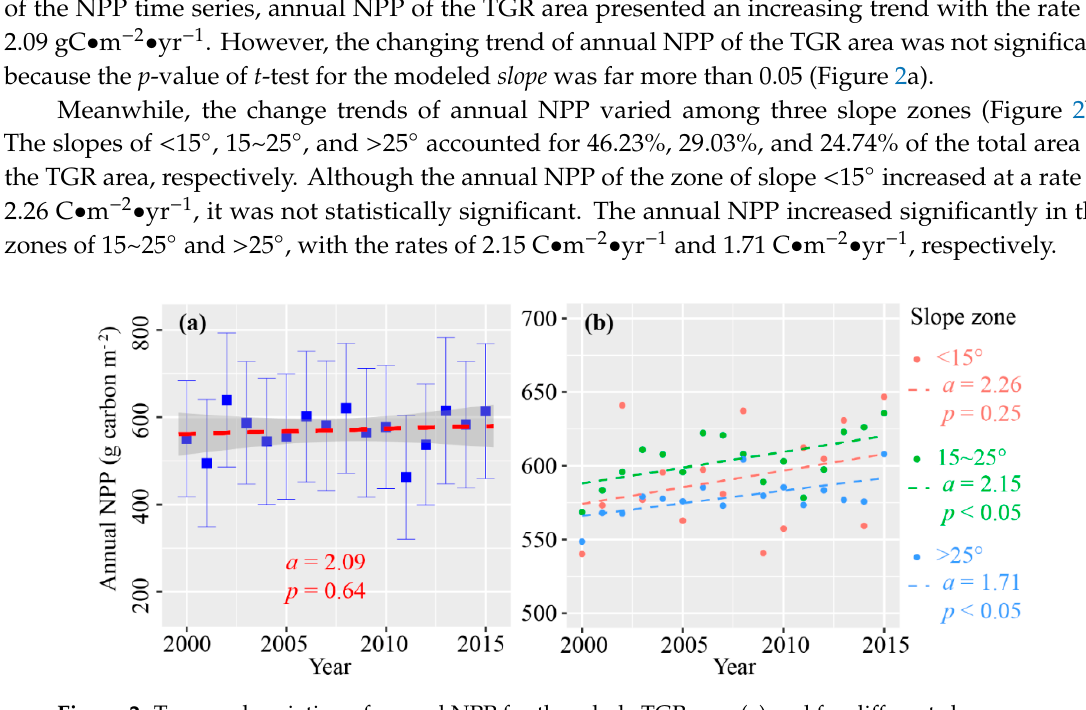
Figure 2. Temporal variation of annual NPP for the whole TGR area ( a ) and for di ff erent slope zones ( b ). Note: The dotted line indicates the linear fitting from 2000 to 2015, the a describes the changing trend. Meanwhile, the t statistic was applied to test the significance of the modeled slope , and the p value documents the significance. In the figure ( a ), error bars extending from the means document the standard deviation of Annual NPP, while the gray region is the 95% confidence intervals of the linear